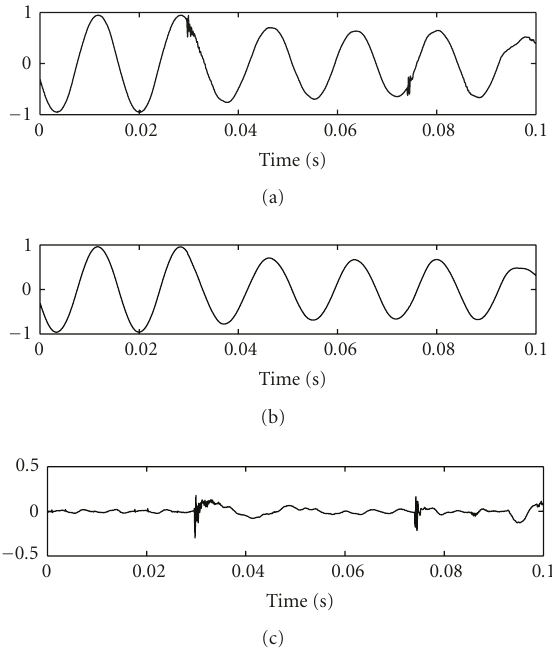
Figure 13: (a) Signal { x ( n ) } , (b) signal { f ( n ) } , (c) signal { u ( n ) } .